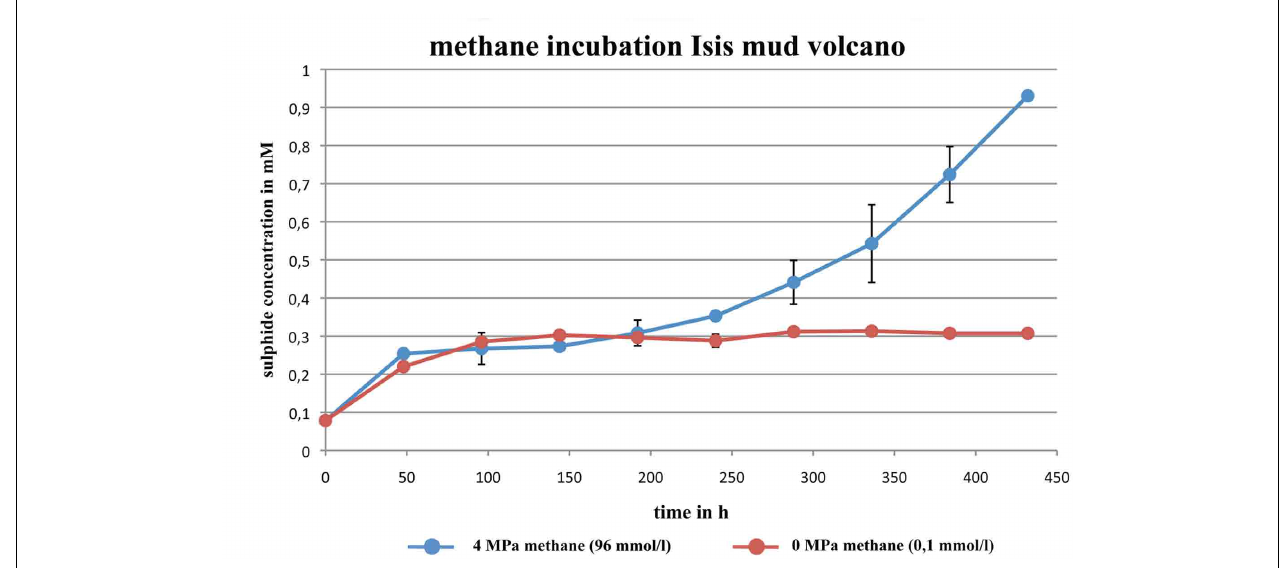
FIGURE 5 | Incubation of sediment samples from Isis mud volcano (IMV). Ten cubic centimeter of sediment were incubated for 432h at 10MPa and 23˚C. Incubations were performed with 4MPa methane (blue circles) and without addition of methane (red circles).